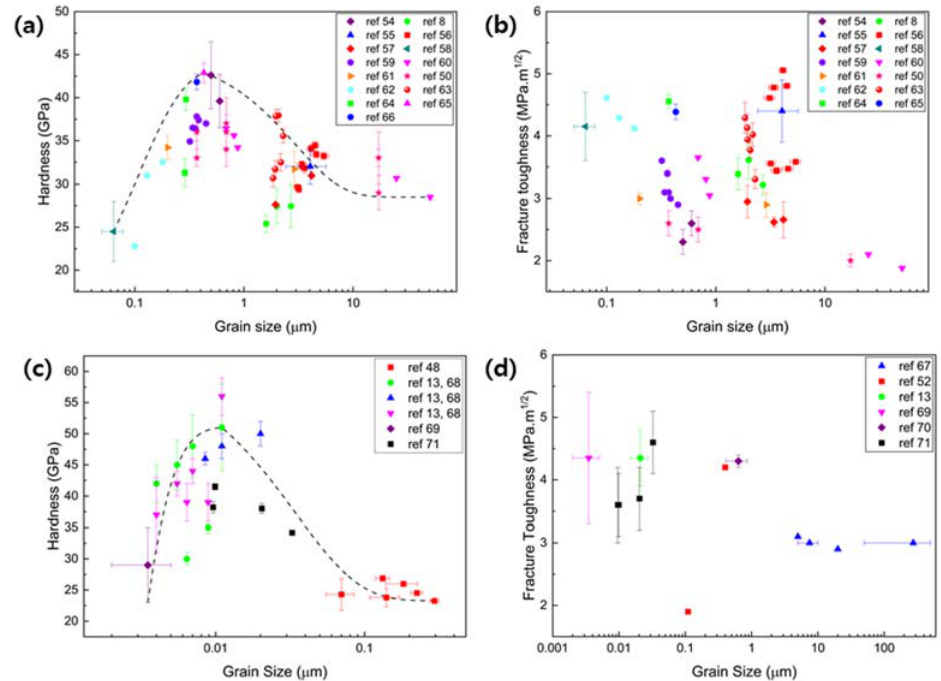
Figure 1. Grain size dependence curve of, ( a ) hardness of B 4 C, ( b ) fracture toughness of B 4 C [8,50,54– 66], ( c ) hardness of β‐ SiC, and ( d ) fracture toughness of β‐ SiC